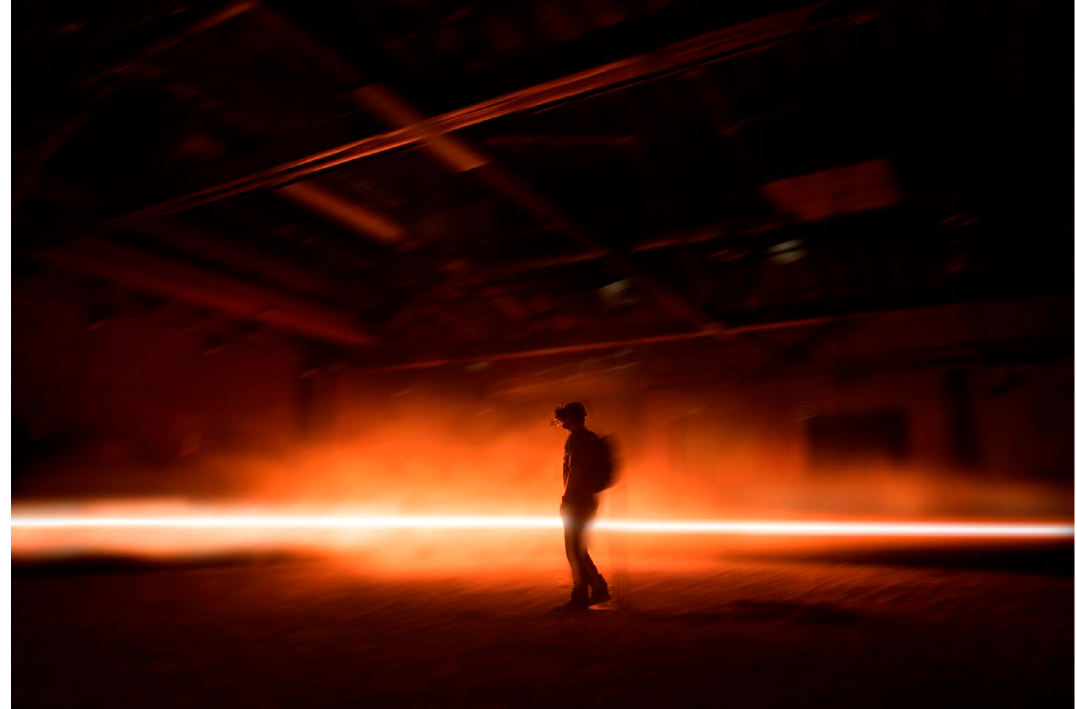
Figure 1. Carne y Arena—A user in the experience , 2017. Photo credit: Emmanuel